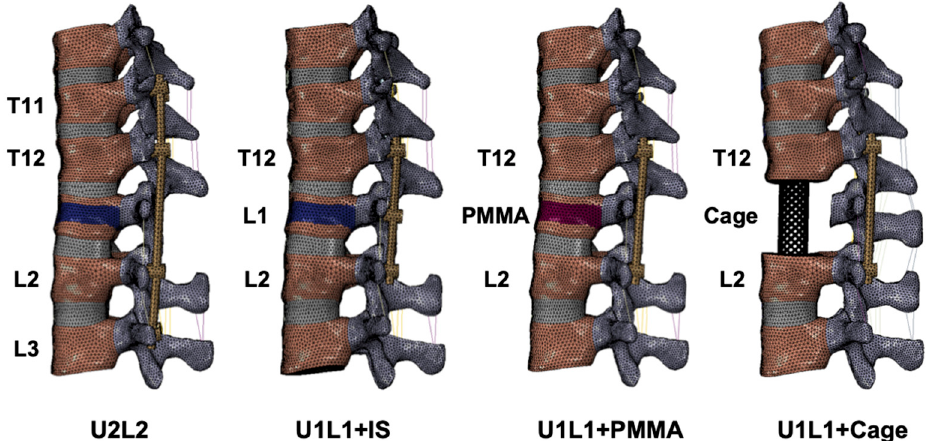
Figure 2. Different spinal reconstruction constructs. Four spinal reconstruction constructs simulated in this study including long-segment instrumentation (U2L2), short-segment instrumentation with intermediate screw (U1L1+IS), and TCSR constructs (U1L1+PMMA and U1L1+Cage). The weakened materials were indicated in blue, and PMMA was indicated in red.